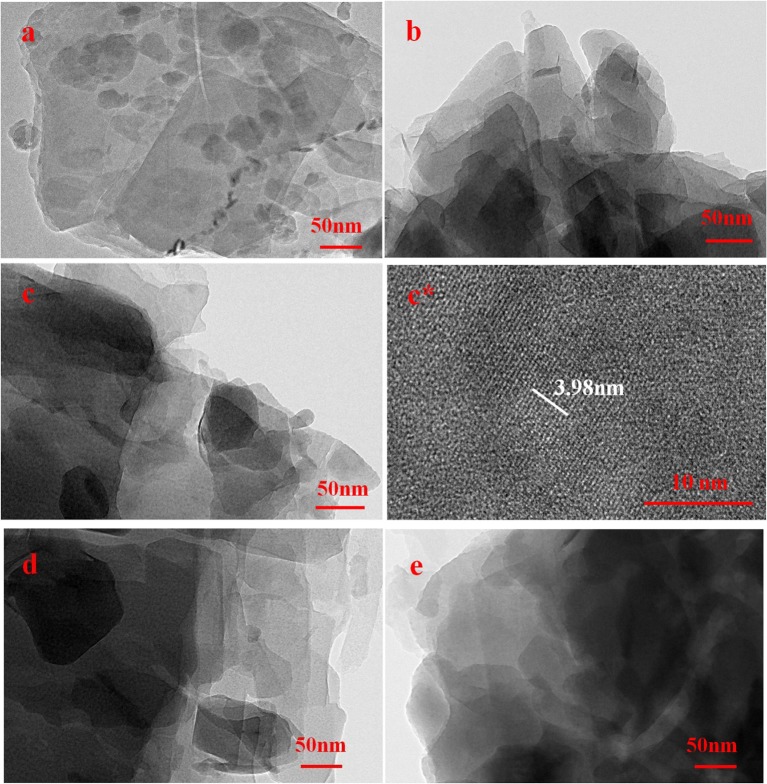
TEM photographs of clinoptilolites: (a). C-0, (b). C-1, (c,c*). C-2, (d). C-3, (e). C-4.